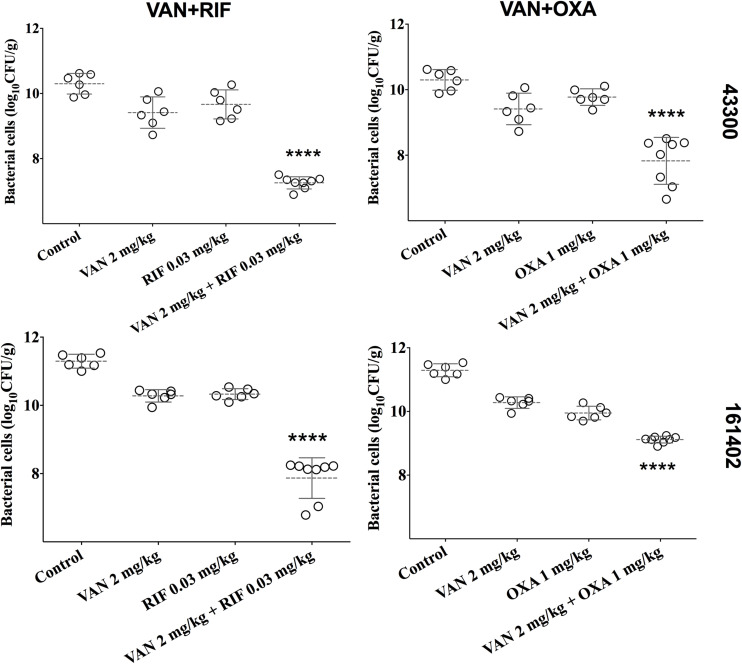
Bacterial densities from mouse thigh muscles (log cfu/g) after 24 h of monotherapy or combination therapy for the two pairwise drugs against ATCC 43300 and #161402, respectively. ****P < 0.001 by the one-way ANOVA.